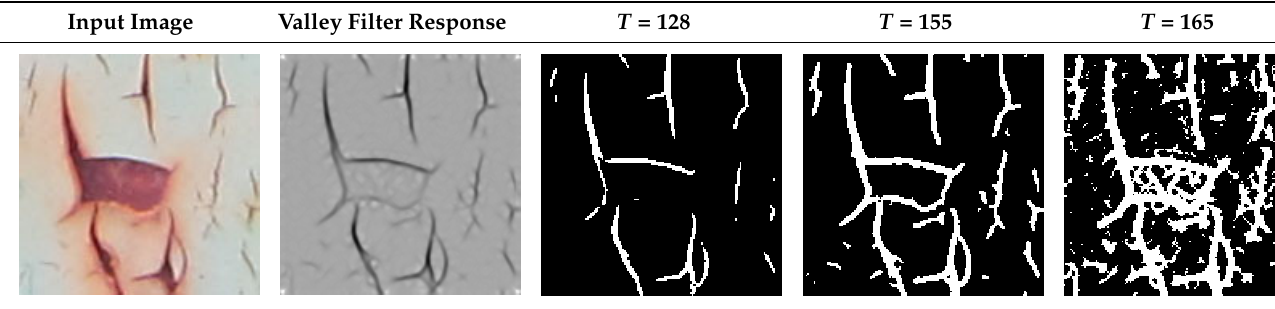
Table 4. Examples of valley detection for different threshold values T .